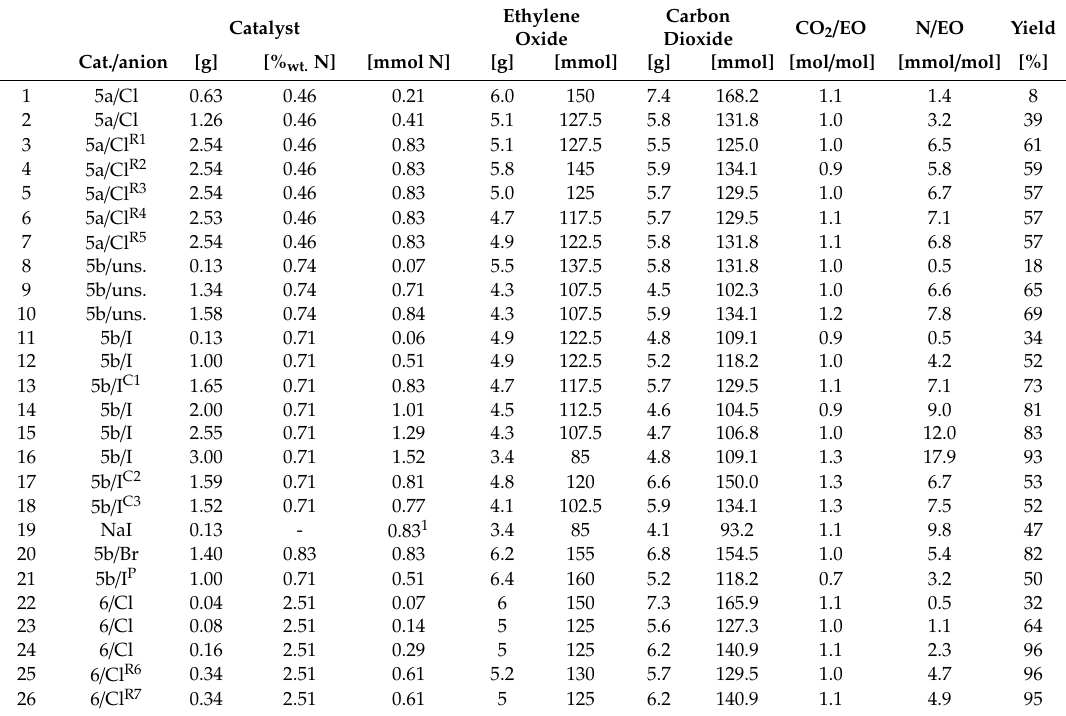
Ethylene Carbon CO 2 / EO N / EO Yield Oxide Dioxide